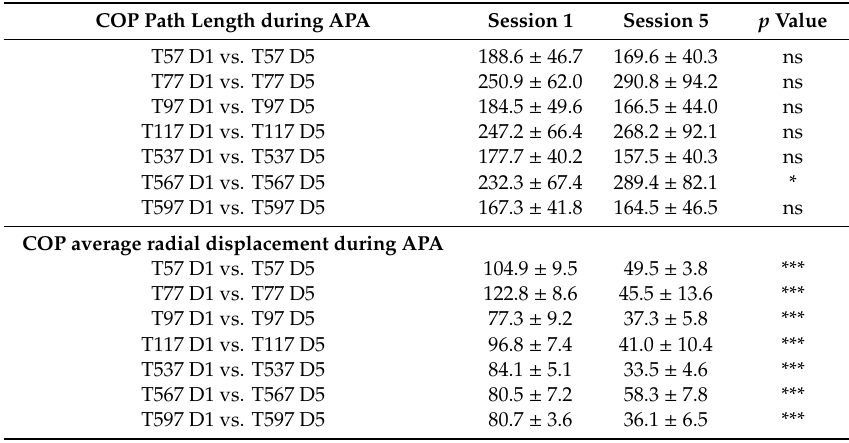
Table 5. Comparison of COP path length and COP average radial displacement values during anticipatory postural adjustment (APA) between corresponding times of session 1 and 5 when pace changes (3 seconds interval before change). D1 corresponds to session 1 and D5 to session 5. Values correspond to means ± SD of the mean. p < 0.05 (*), p < 0.001 (***).